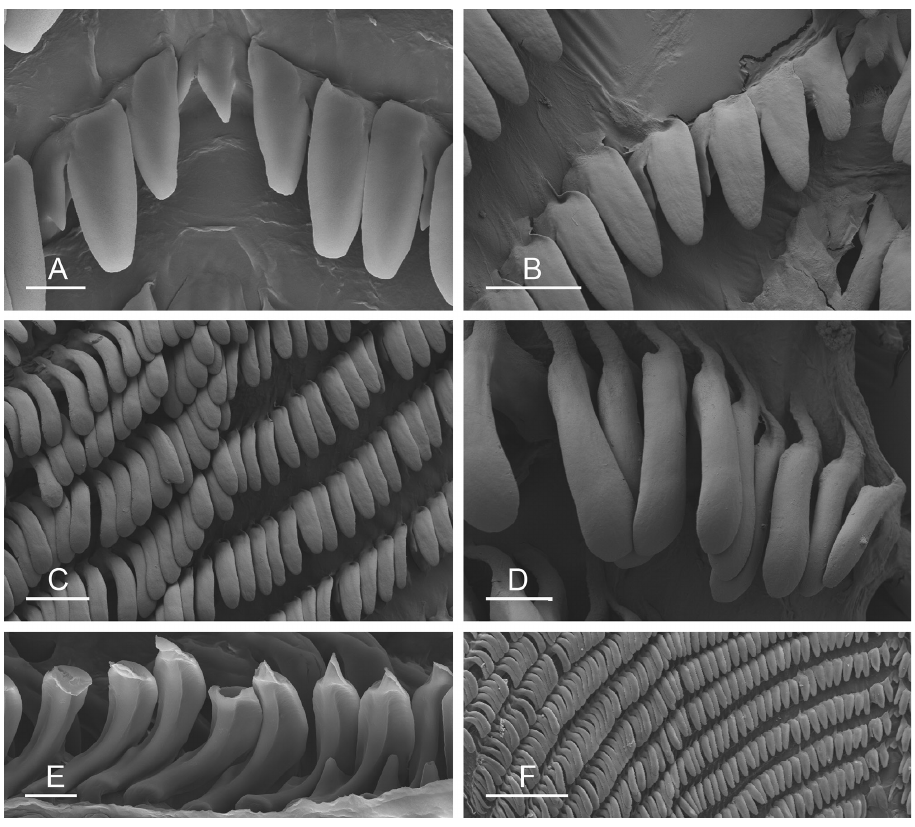
Figure 51. Radula, Wallaconchis achleitneri , Australia, Queensland (MTQ st117). A Rachidian and innermost lateral teeth, scale bar 6 μm [#1] B Rachidian and innermost lateral teeth, holotype, scale bar 20 μm [3534] C Transition between inner lateral teeth and outer lateral teeth, holotype, scale bar 30 μm [3534] D Outermost lateral teeth, holotype, scale bar 10 μm [3534] E Lateral teeth with basal lateral spine decreasing in size from right to left, scale bar 10 μm [#1] F Left lateral teeth, scale bar 100 μm [#2]. Color and morphology of live animals (Fig. 50C–E). The dorsal notum is brownish grey. The ocular tentacles are orange-brown. The hyponotum and foot are